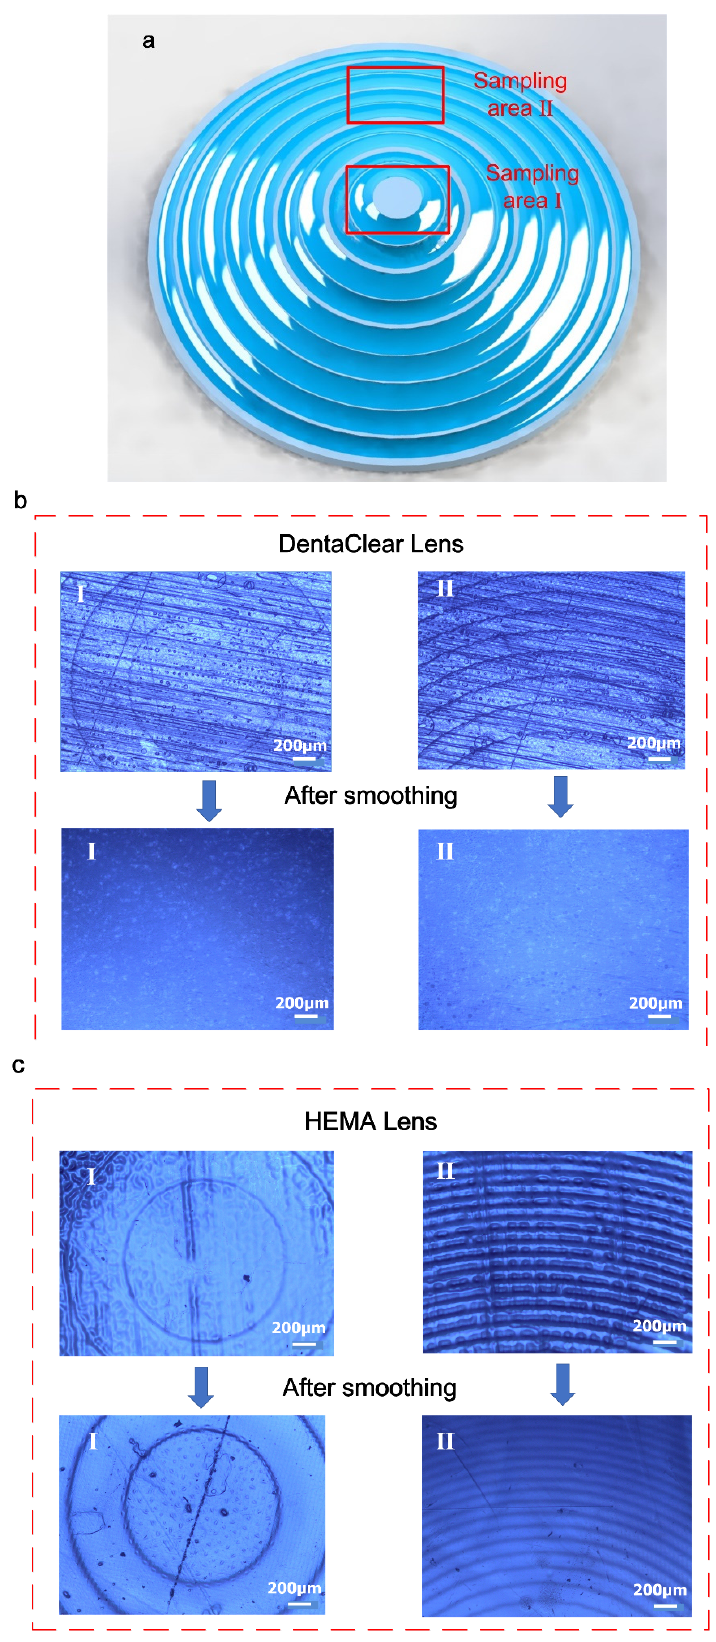
Figure 6. ( a ) Schematic diagram of the sampling areas under an optical microscope. ( b ) Optical microscope pictures of DentaClear lenses. ( c ) Optical microscope pictures of HEMA lenses.